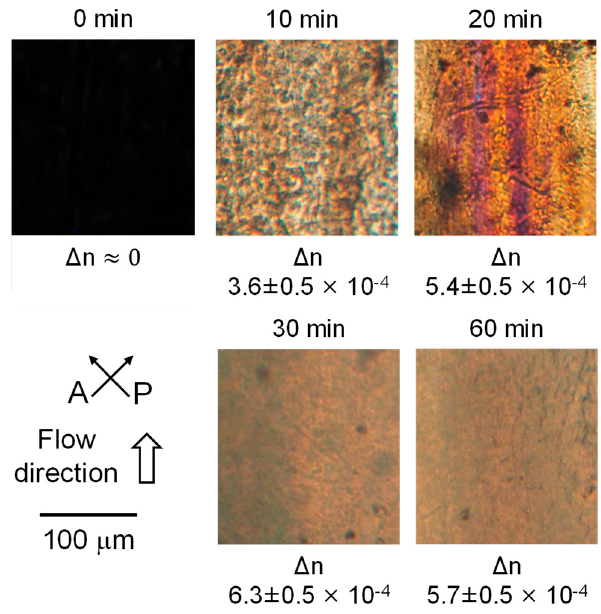
Figure 7. Polarized optical microscope images of the sheared films after annealing at 80 ◦ C for various periods. The annealing periods were denoted at the top of the pictures, and the birefringence values were at the bottom of the